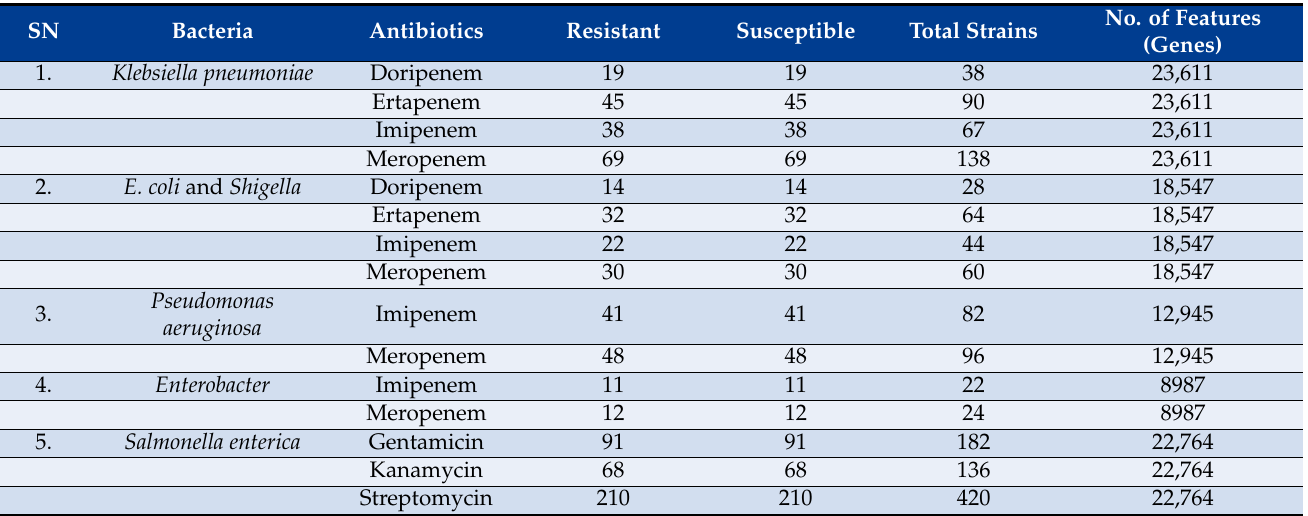
Table 1. Description of species groups with numbers of strains resistant and susceptible to antibiotics for each group. Also shown are total number of strains and total number of features (genes) for each species group and antibiotic combination, which were used in training, validation, and testing of different machine learning models in phenotype (resistance/susceptible)